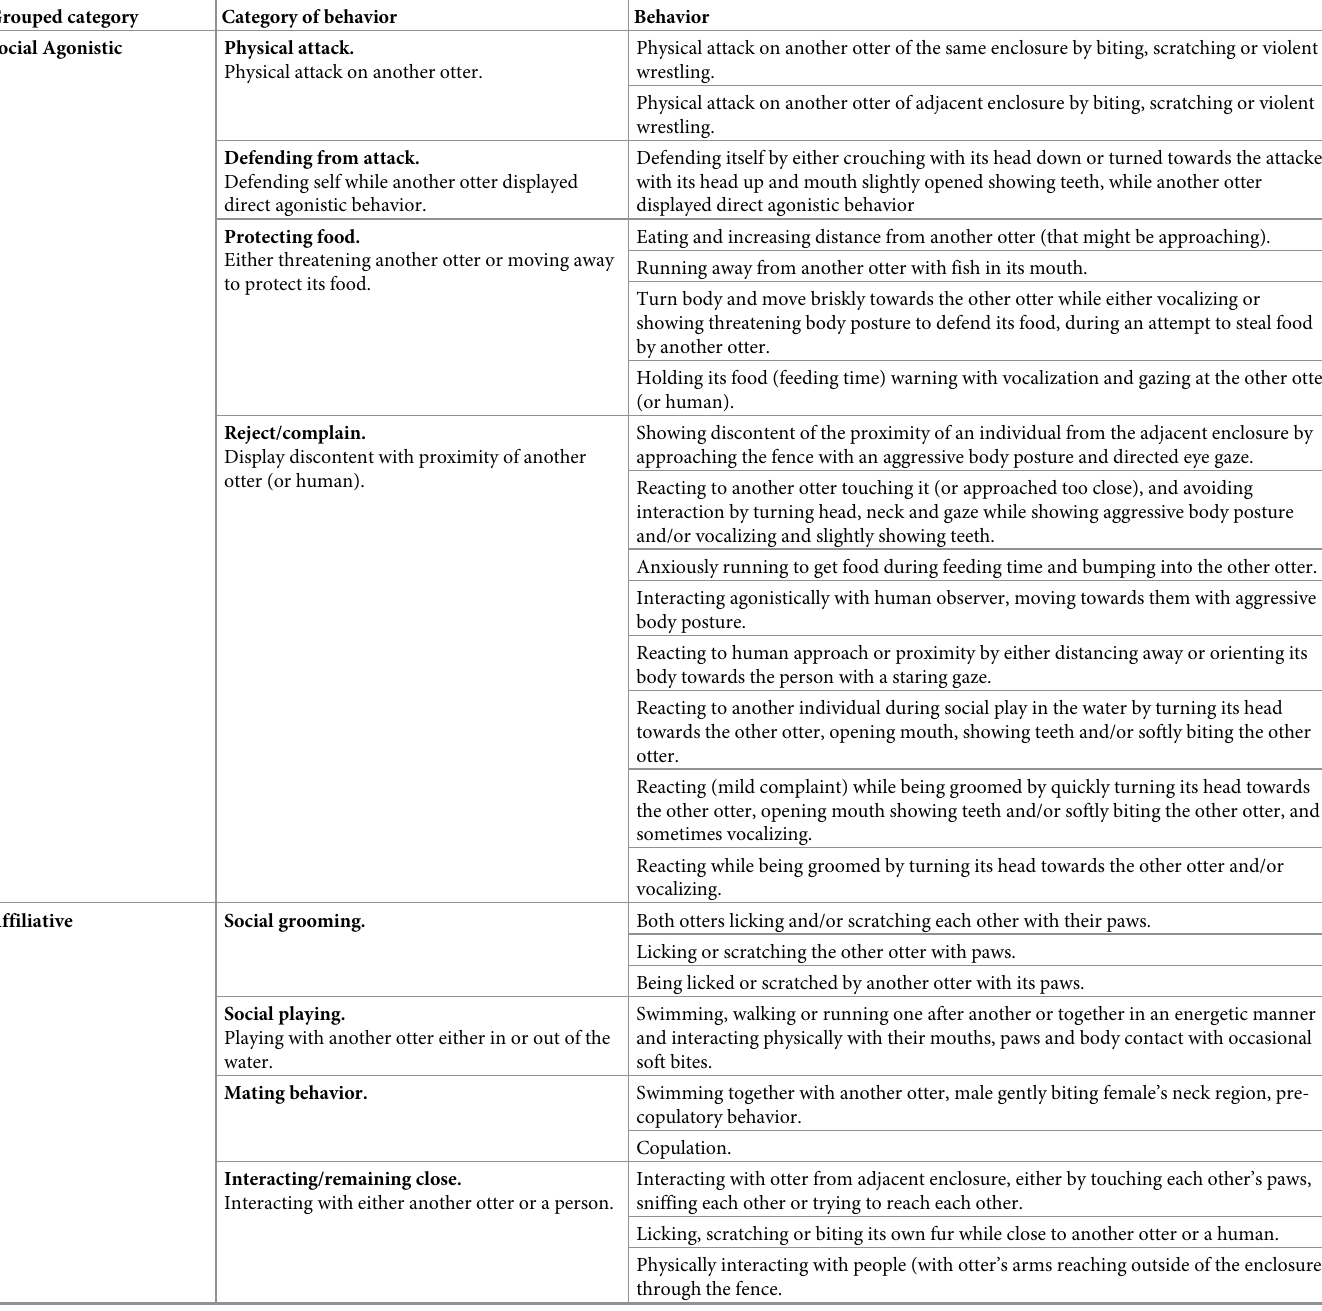
Table 1. Behavioral categories and descriptions associated with the vocal repertoire of the neotropical river otter. Grouped